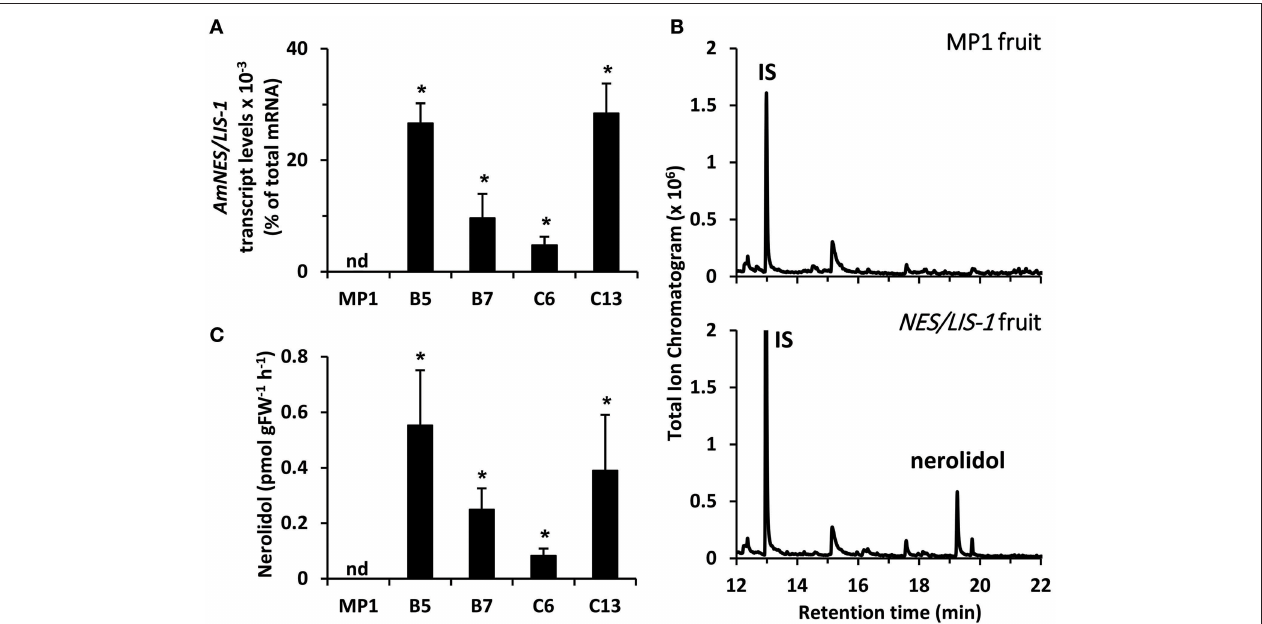
FIGURE 2 | Profiling of transgenic tomato lines overexpressing AmNES/LIS-1 under control of the PG promoter. (A) Transcript levels of AmNES/LIS-1 in fruits (Br + 3 stage) of MP1 control and AmNES/LIS-1 lines B5, B7, C6, and C13 determined by qRT-PCR (means ± SEM, n = 3 biological replicates). (B) Profiling of terpenes collected as emitted volatiles from ripe tomato fruits (MP1 control and AmNES/LIS-1 line B5) and analyzed by GC-MS. IS, internal standard. (C) Quantitative changes in amounts of nerolidol collected as emitted volatile from fruits of MP1 and AmNES/LIS-1 lines. Data are means ± SEM ( n ≥ 3). * P < 0.05 AmNES/LIS-1 lines relative